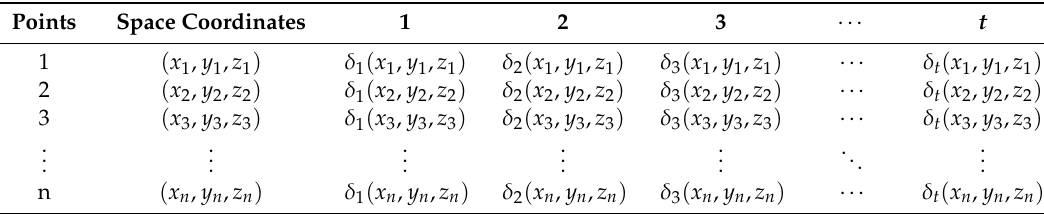
Table 4. Space panel data structure.